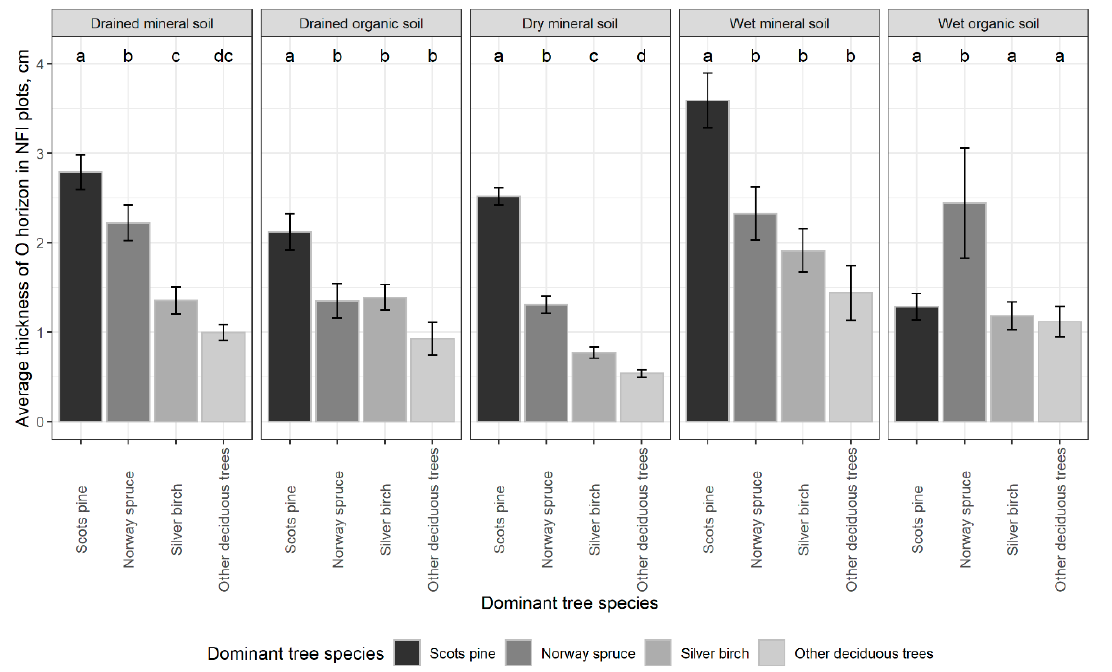
Figure 2. Average thickness of the O horizon in forest land in Latvia by dominant tree species (Scots pine ( Pinus sylvestris L.), Norway spruce ( Picea abies (L.) H.Karst.), silver Birch ( Betula pendula Roth) and other deciduous trees). The division into groups based on soil types and moisture conditions is based on forest site types according to the national forest classification. Error bars represent standard errors. Different lower-case letters show statistically significant differences ( p < 0.05, α = 0.05) in average values between different dominant tree species within a group of soil type and moisture conditions.